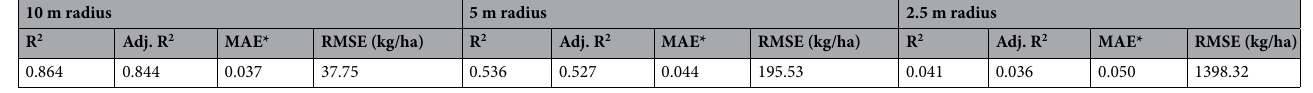
Table 7. Summary of model statistics, for the Model II–Log-transformed dependent variable (i.e. AGB) and Raw independent variables, across the 10 m, 5 m, and 2.5 m radius plot-size.